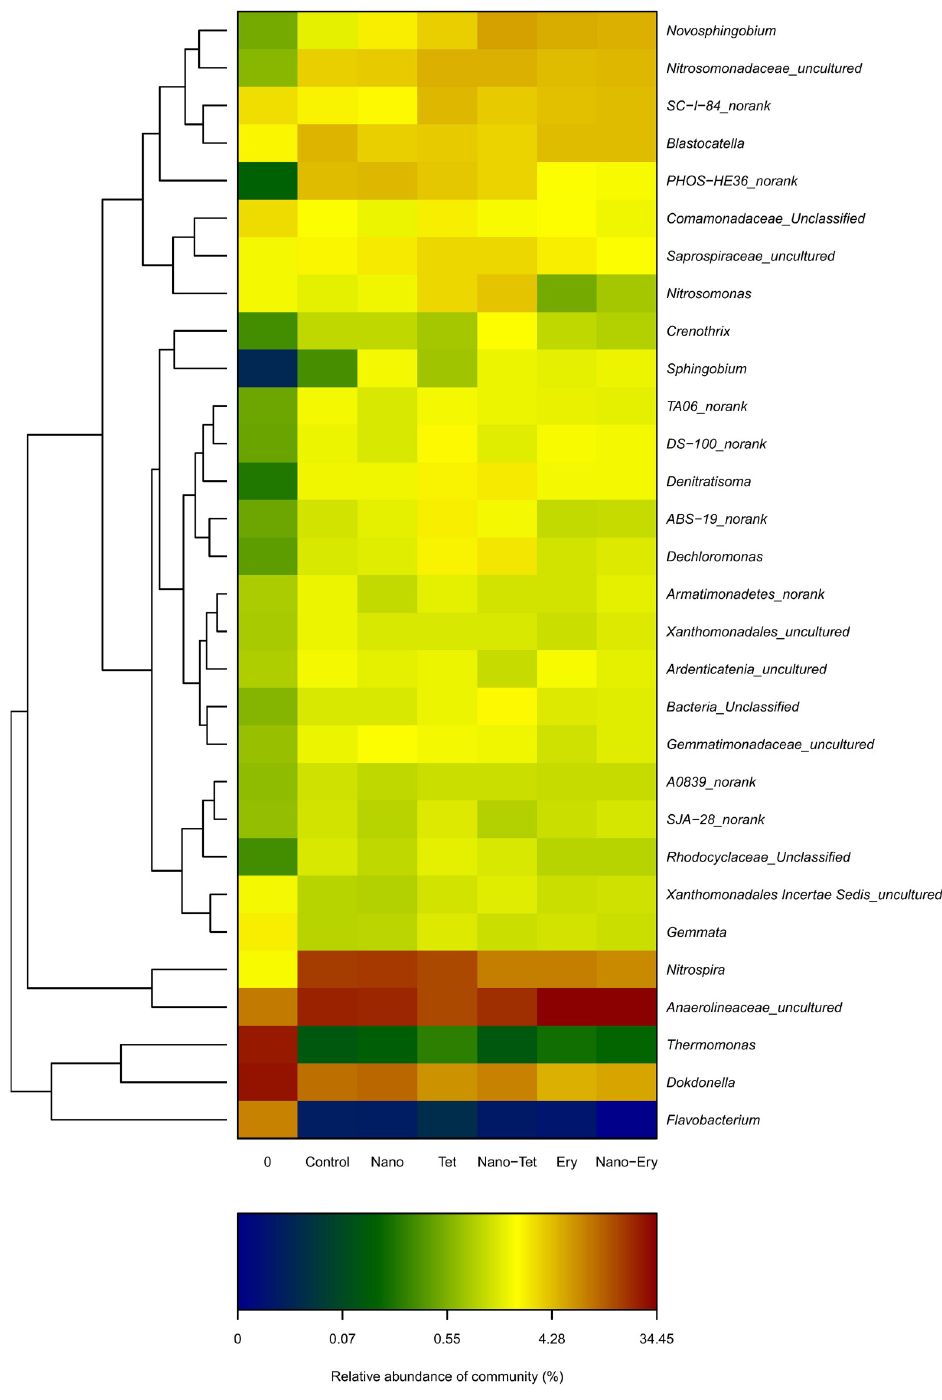
Fig 4. Bacterial community heatmap analysis of all samples at genus level. Top 30 genera were selected and the color intensity of scale indicates relative abundance of each OTU read.